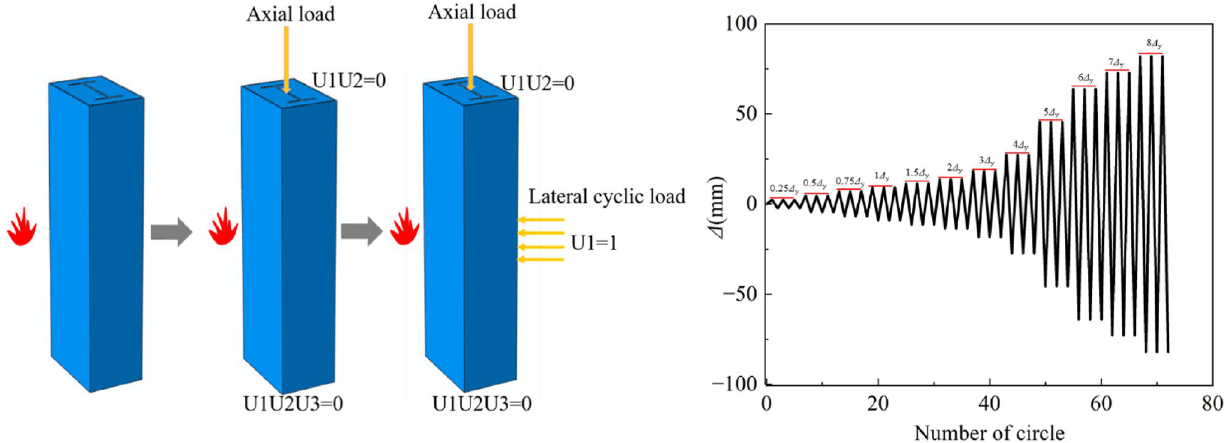
Figure 3. Process of loading and boundary